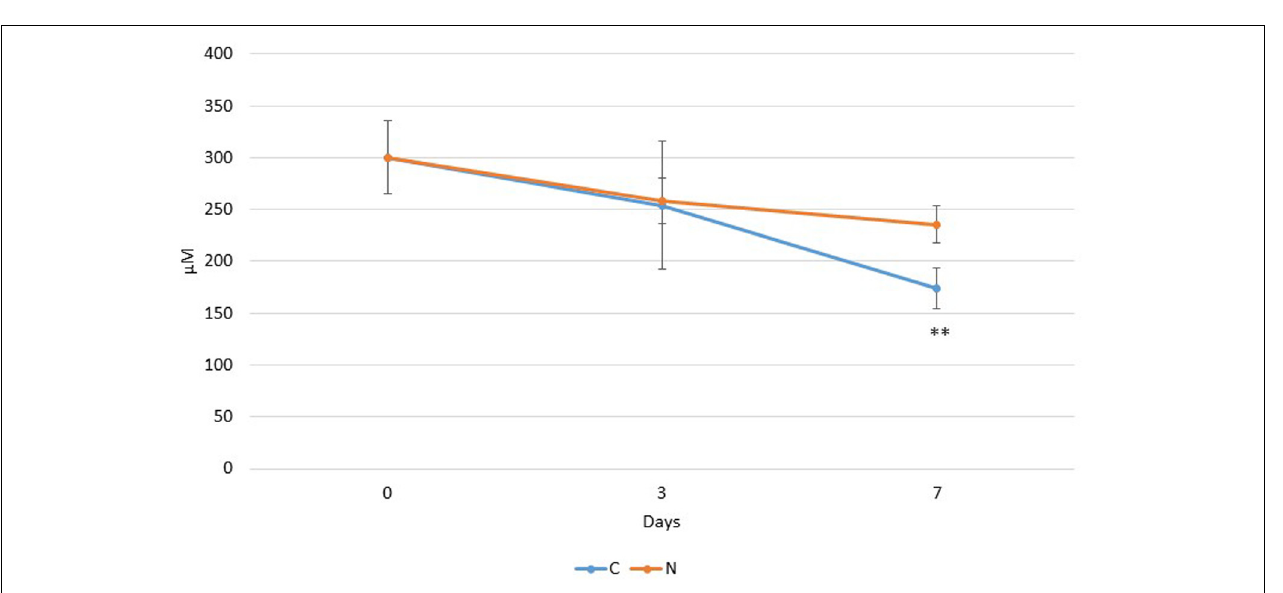
FIGURE 2 | Trends in total phospholipid concentrations (in µ M), over time detected in raw milk samples (M1, M2, and M3) stored at 6 ◦ C (C), or additionally flushed with N 2 (N). Note: The mean values ( n = 3) are significantly different between C7 and N7 ( p < 0.01) ( ∗∗